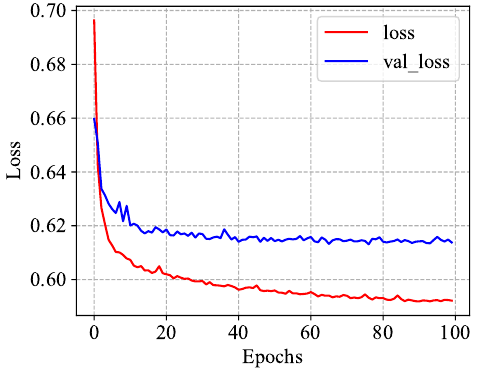
Figure 14. MSE loss function training